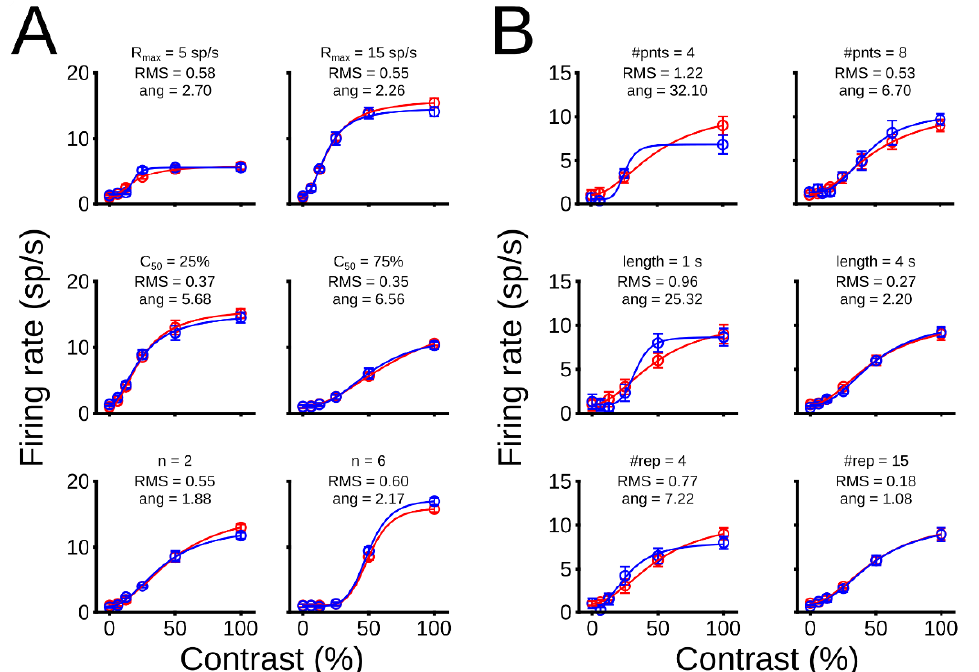
Figure 3. Examples of simulations of CRFs for different parameters and experimental conditions. ( A ) Variation of parameters of CRFs. Top, middle and bottom panels show changes of R max , C 50 , and n , respectively. Parameters for simulations in top panels with C 50 = 20%, n = 2, and B = 1 sp/s/; middle panels R max = 15 sp/s, n = 2, and B = 1 sp/s; bottom panels, R max = 15, C 50 = 25%, and B = 1 sp/s. For this set of simulations, number of points = 6, trial length = 2 s, and number of repetitions = 10. ( B ) Variation of conditions of CRFs. Top, middle and bottom panels show changes of the number of points (#pnts), length of trials (len), and number of repetitions (#rep), respectively. Conditions for simulations in top panels, len = 1, and #rep = 6; middle panels, #pnts = 6, and #reps = 6; bottom panels, #pnts = 6, len = 1. For this set of simulations, R max = 10, C 50 = 50%, B = 1 sp/s, and n = 2. A logarithmic scale was used for all these simulations.